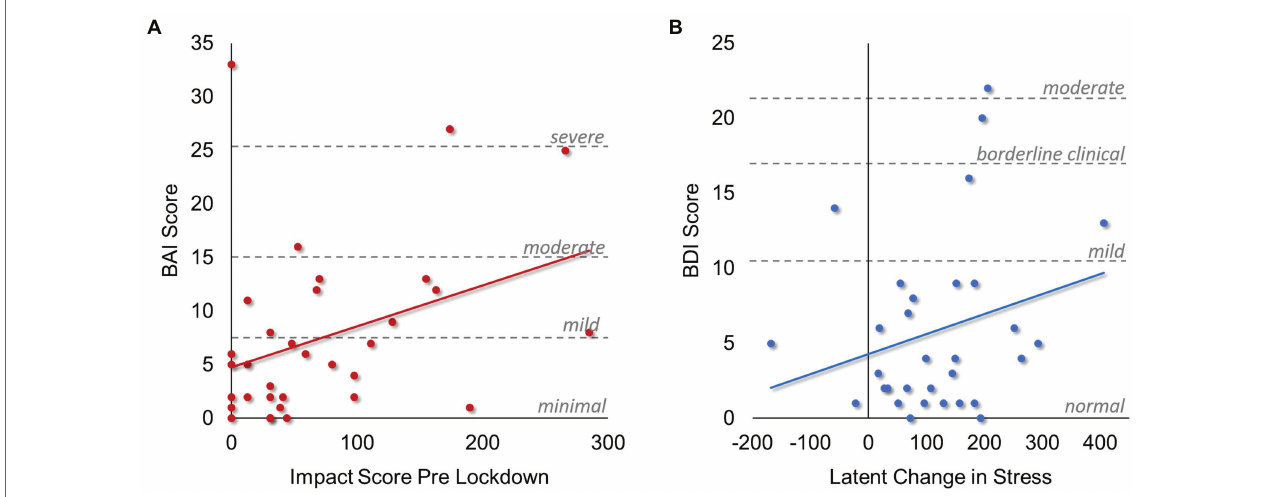
FIGURE 4 | Associations between Stress, Anxiety, and Depression. Scatterplots demonstrating significant associations found in the latent change score model of life stress impact, depression, and anxiety. (A) Associations between self-reported anxiety scores (BAI) and life stress impact scores prior to local lockdowns beginning. Dashed gray lines and associated labels demonstrate different clinical cutoff criteria for anxiety scores obtained from the BAI, with “moderate” and “severe” categories considered clinically significant. (B) Associations between self-reported depression scores (BDI) and the latent change in life stress impact scores assessed as the difference between post-and pre-lockdown stress impact scores. Dashed gray lines and associated labels demonstrate different clinical cutoff criteria for depression scores obtained from the BDI, with the “moderate” category considered clinically